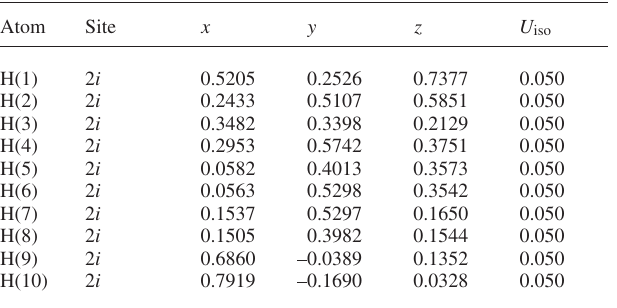
Table 2. Atomic coordinates and displacement parameters (in Å 2 )